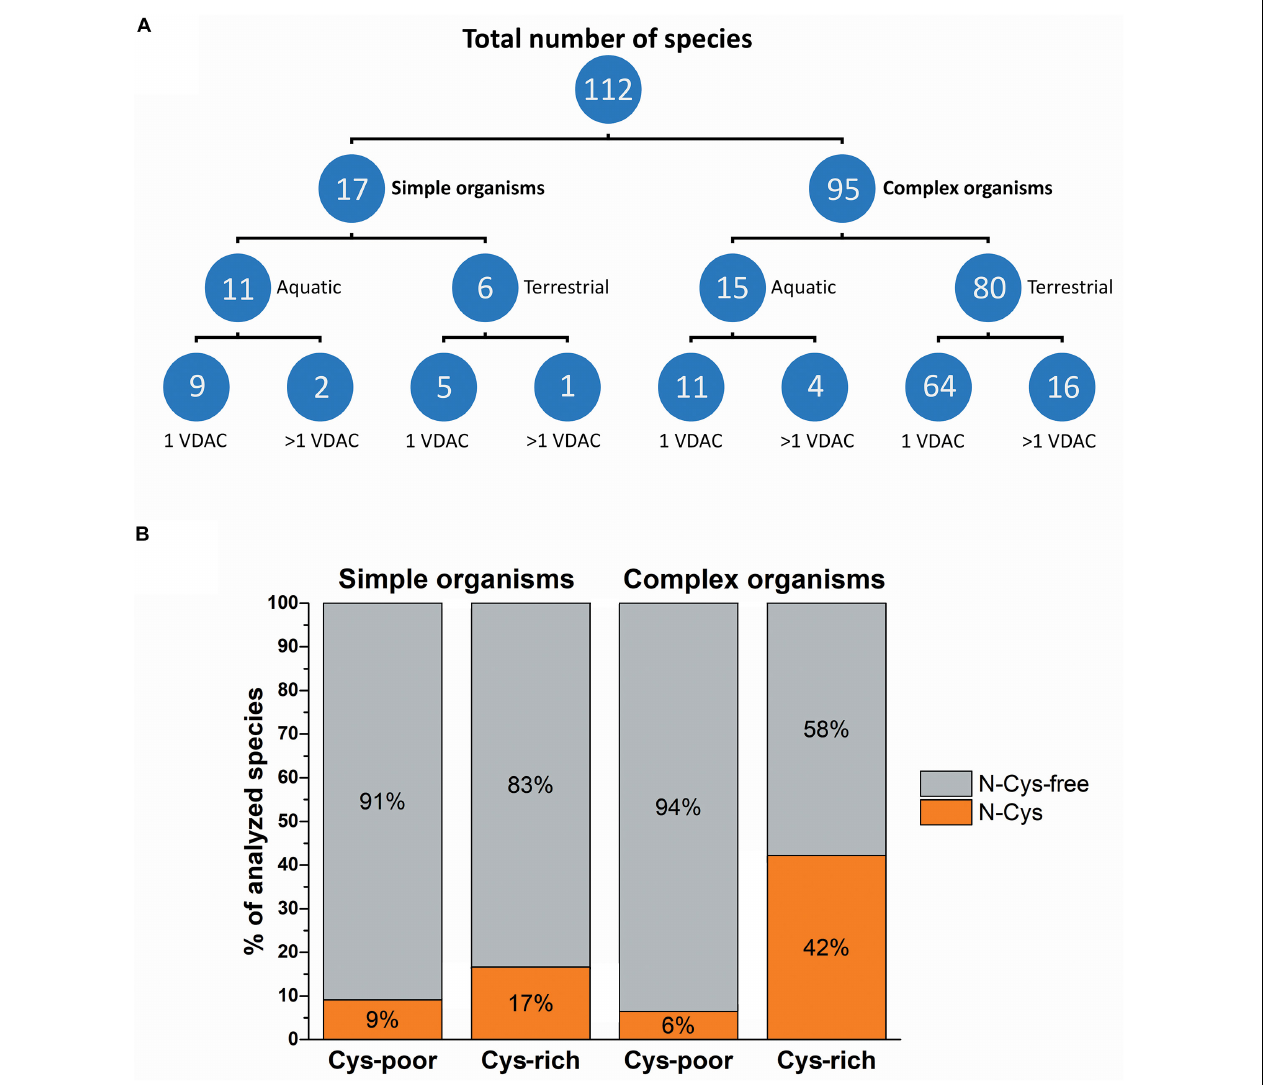
FIGURE 1 | The complexity of organisms and their inhabited environment in relation to the number of VDAC variants and their cysteine residue content. (A) The number of organisms classified in terms of complexity, inhabited environment, and the number of genes encoding VDAC proteins. (B) Classification of organisms based on the number and localization of cysteine residues in VDAC proteins. Cys-poor: a set of organisms in which only one VDAC variant or at least one VDAC paralog (if present) contains fewer than two cysteine residues in the primary structure; Cys-rich: a set of organisms in which only one VDAC variant or all VDAC paralogs (if present) have more than one cysteine residue in the primary structure; N-Cys: a set of organisms in which only one VDAC variant or all VDAC paralogs (if present) have at least one N-terminal cysteine residue; N-Cys-free: a set of organisms that have at least one VDAC variant with no N-terminal cysteine residue.